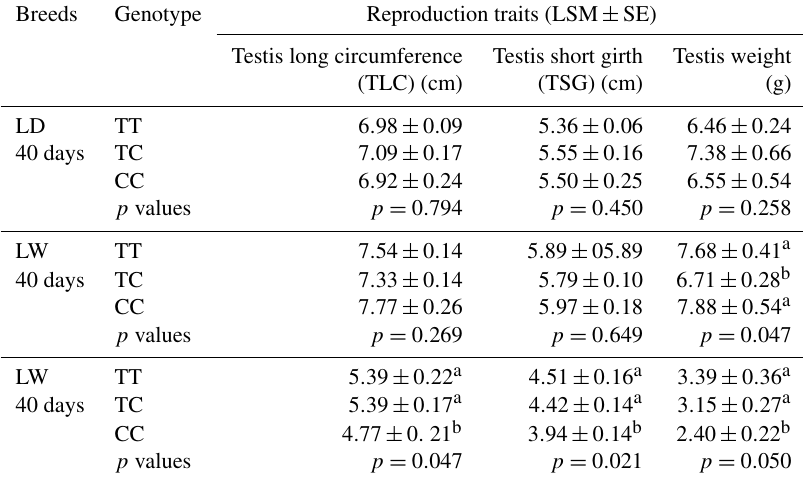
Table 3. Relationship between the SNP- Stu I of the TMEM95 gene and reproduction traits in pig (least squares means, LSM a ± standard error, SE) ( p < 0 .